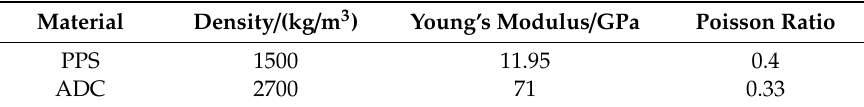
Table 1. Material properties of the structure